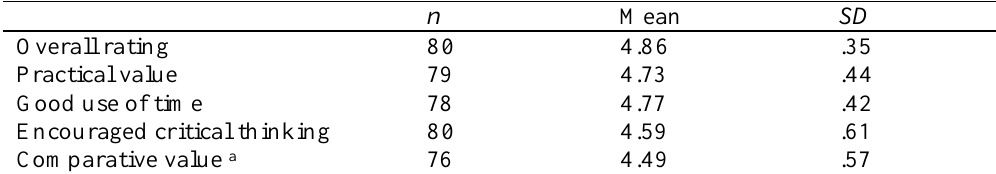
Descriptive Statistics of General Evaluation Items